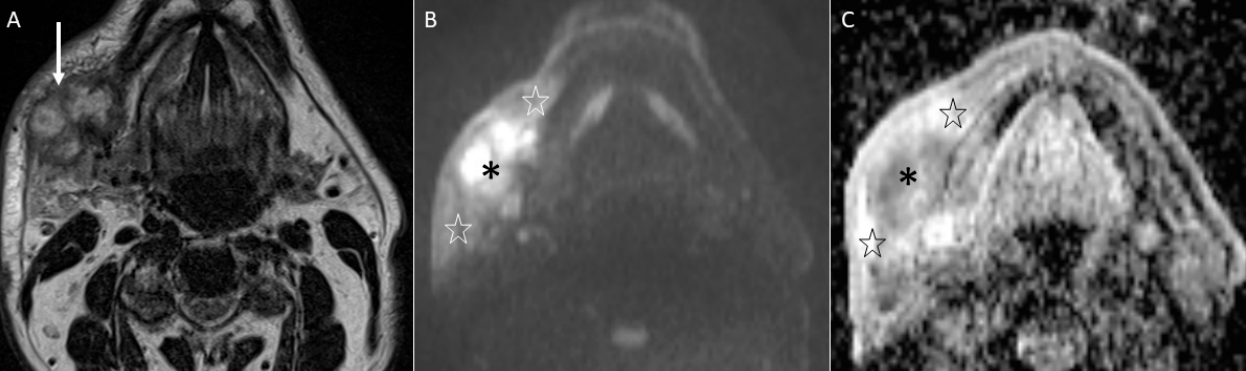
Figure 4. Odontogenic abscess with surrounding phlegmon of the right cheek soft tissues. ( A ) T2 axial image showing the high signal of the abscess area (white arrow). Note the swollen appearance of the soft tissues of the right cheek. ( B ) DWI trace (b = 1000). The abscess (*) shows high signal, whereas the surrounding phlegmon (stars in Figure 4B) has a lower signal. ( C ) ADC map. The purulent tissue of the abscess (*) has low ADC values (0.84 × 10 − 3 mm 2 /s, restricted diffusion), while the surrounding phlegmon (stars in Figure 4C) shows high ADC values without restricted diffusion (2.1 × 10 − 3 mm 2 /s).